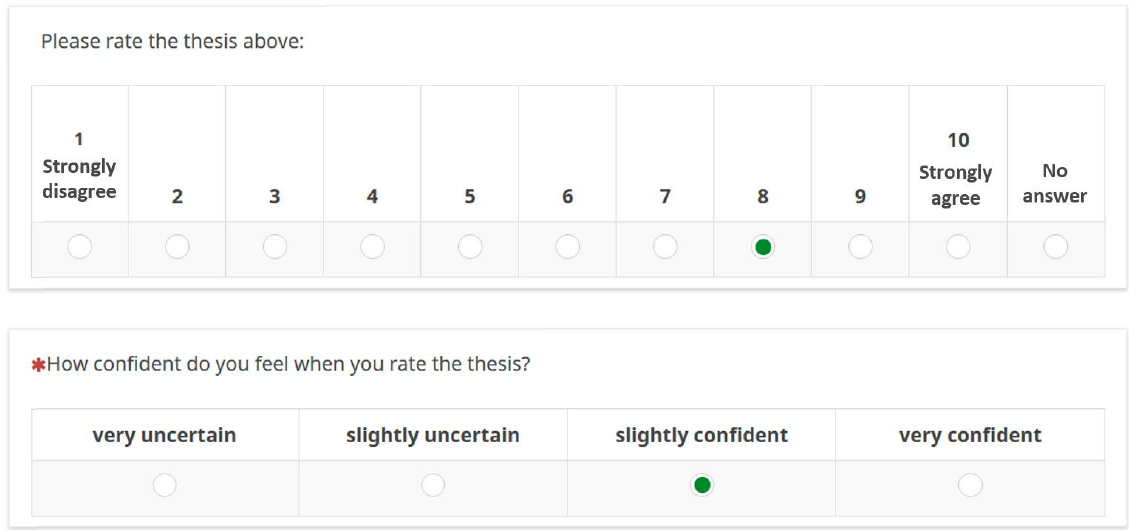
Figure 1. Ten-point rating scale for agreement with the thesis and four-point rating scale for indication of confidence in rating. (* = Question was mandatory if the thesis was rated with a value between 1 and 10).